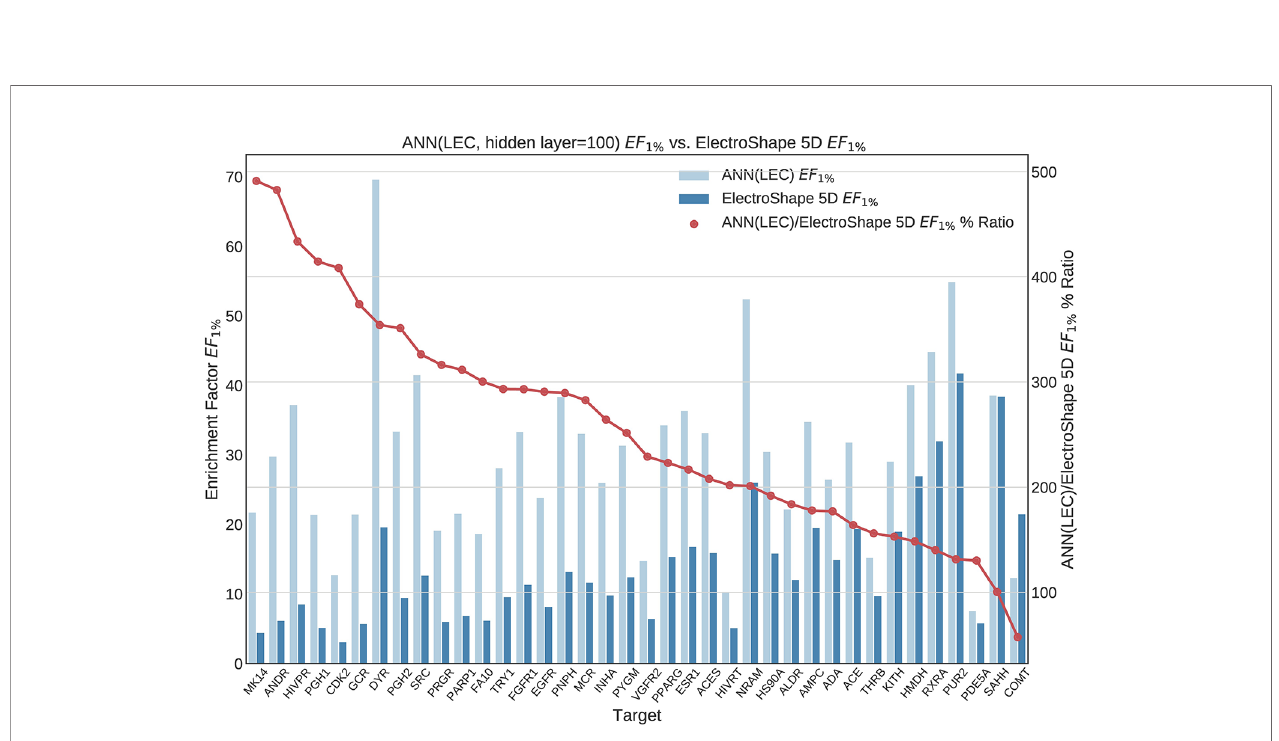
FIGURE 11 | Comparison of Enrichment Factor at 1% obtained by Arti fi cal Neural Networks with 100-node hidden layer with that obtained by ElectroShape 5D using Lowest Energy Conformers. Also plotted is the percentage ratio of the Enrichment Factor score of Arti fi cial Neural Network (ANN) compared to ElectroShape 5D. Mean ratio = 256% ± 107%, max = 491%, min =